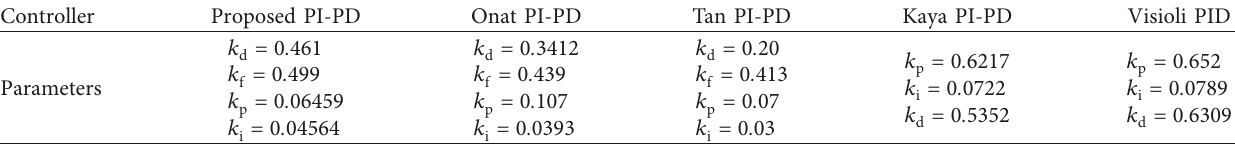
Table 1: Controller parameters comparison of various methods in example A (other data cited from [34]).